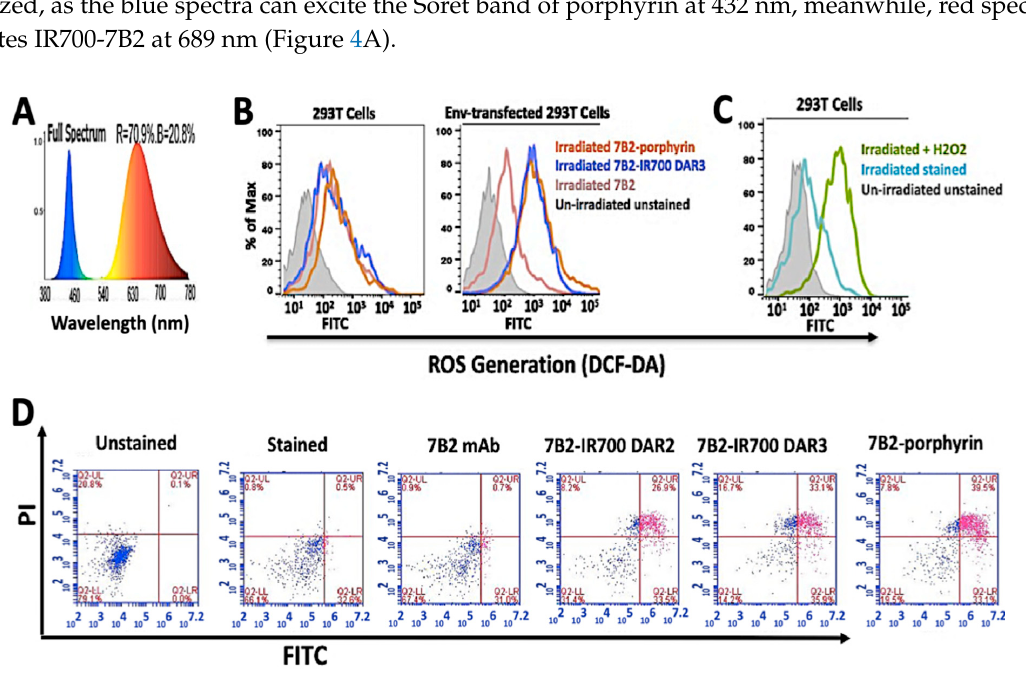
Figure 4. ROS generation and apoptosis assay by PICs. ( A ) The diagram demonstrates a broad spectrum of light (380 − 780 nm) by a homemade LED device (30 mW / cm 2 ) for irradiation of both IR700 and porphyrin PICs, at the same time. Blue spectra can excite the Soret band of porphyrin at 432 nm, meanwhile red spectra excite 7B2-IR700 at 689 nm. ( B ) Samples were kept in the dark (represented by grey) or were irradiated with 50 J / cm 2 . ( C ) As a positive control, 293T cells were treated with 80 µ M H2O2 for 24 h in dark. Control group (without H2O2) was incubated under the same conditions. ( D ) In apoptosis assay by Annexin V - FITC / PI, the Env-transfected cells were incubated with PICs for 4 h, then irradiated. PICs showed cell death due to late apoptosis (purple color in subset Upper Right) after 4 h incubation. Control 7B2 antibody showed neither cell death nor apoptosis sign. ( n =